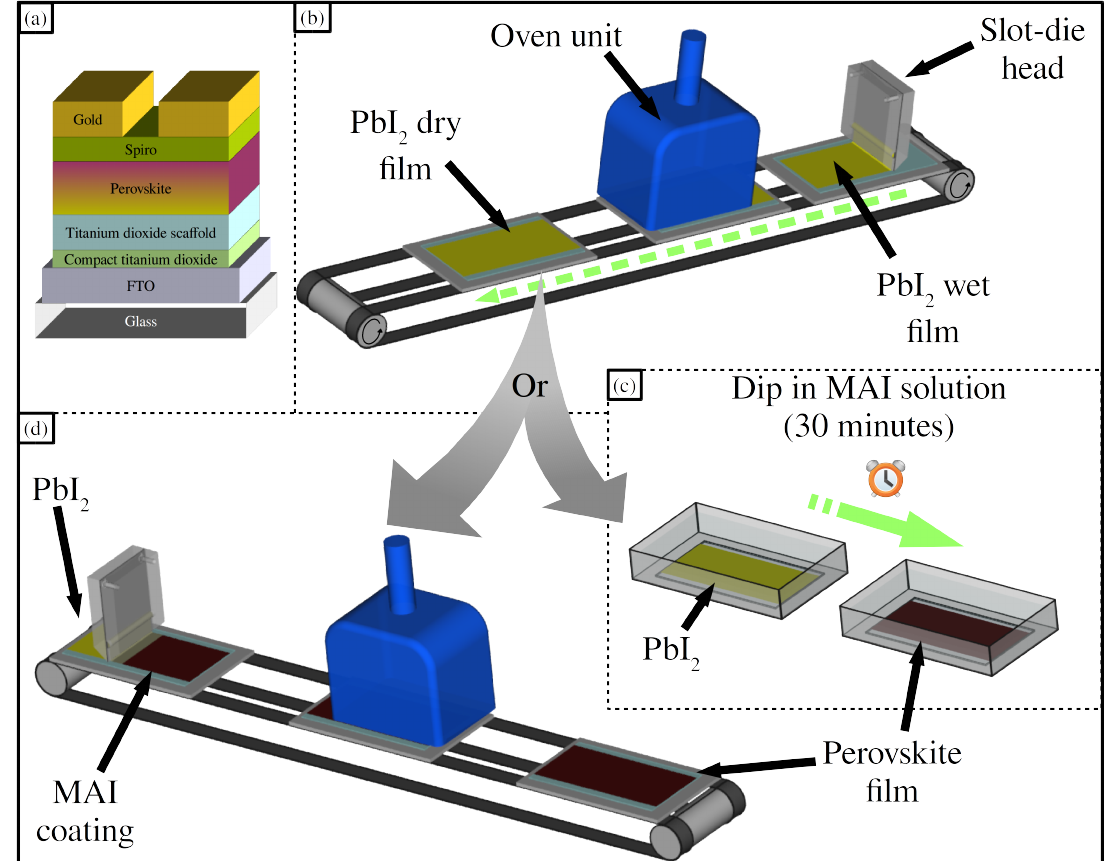
Figure 1. ( a ) The full device stack, ( b ) a schematic of lead iodide slot-die coating, ( c ) dip coating or ( d ) slot-die coating of